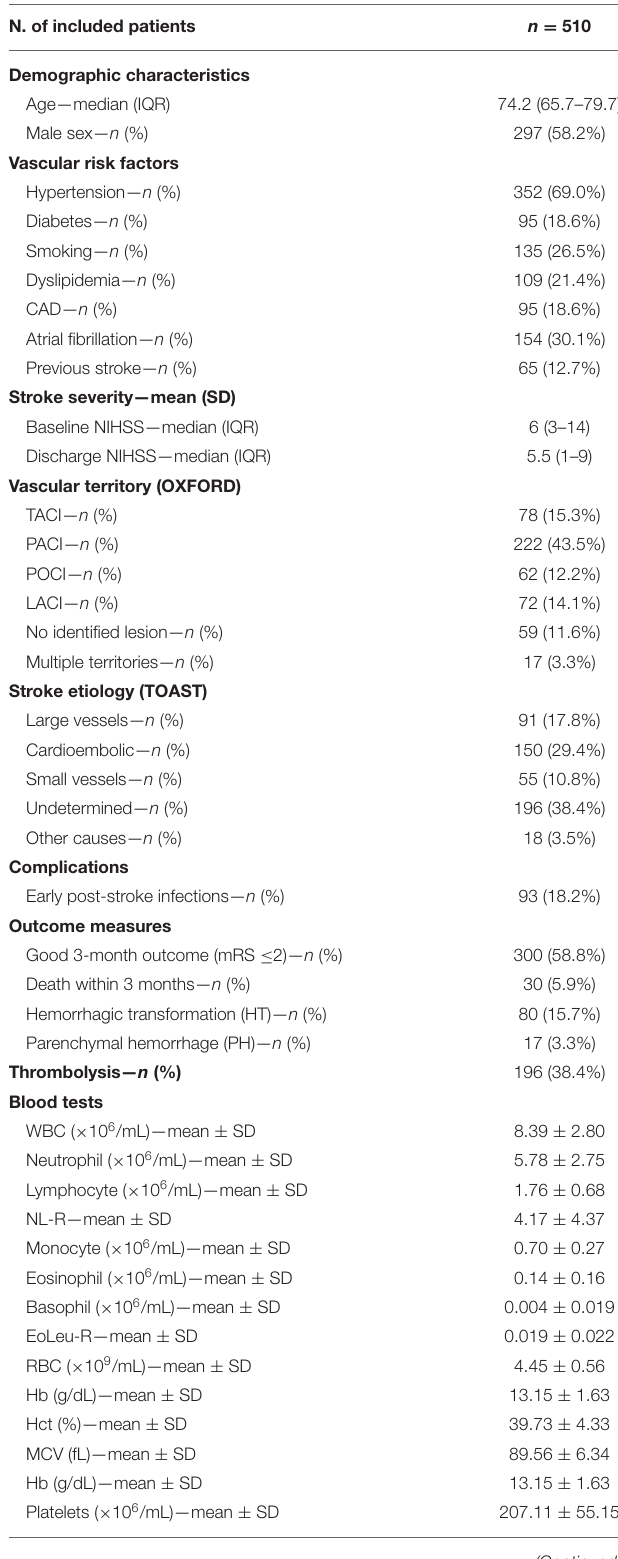
TABLE 1 | Characteristics of the study